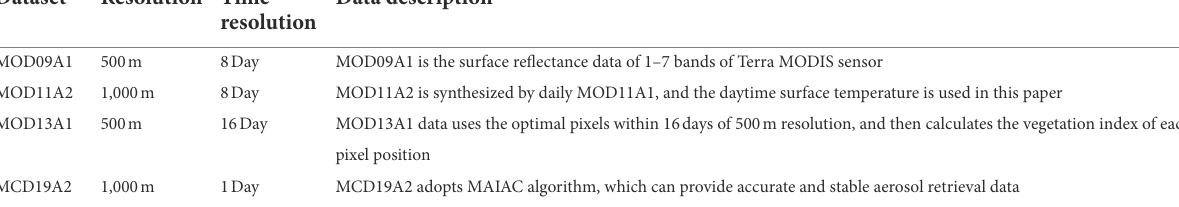
TABLE 2 Data source. Dataset Resolution Time